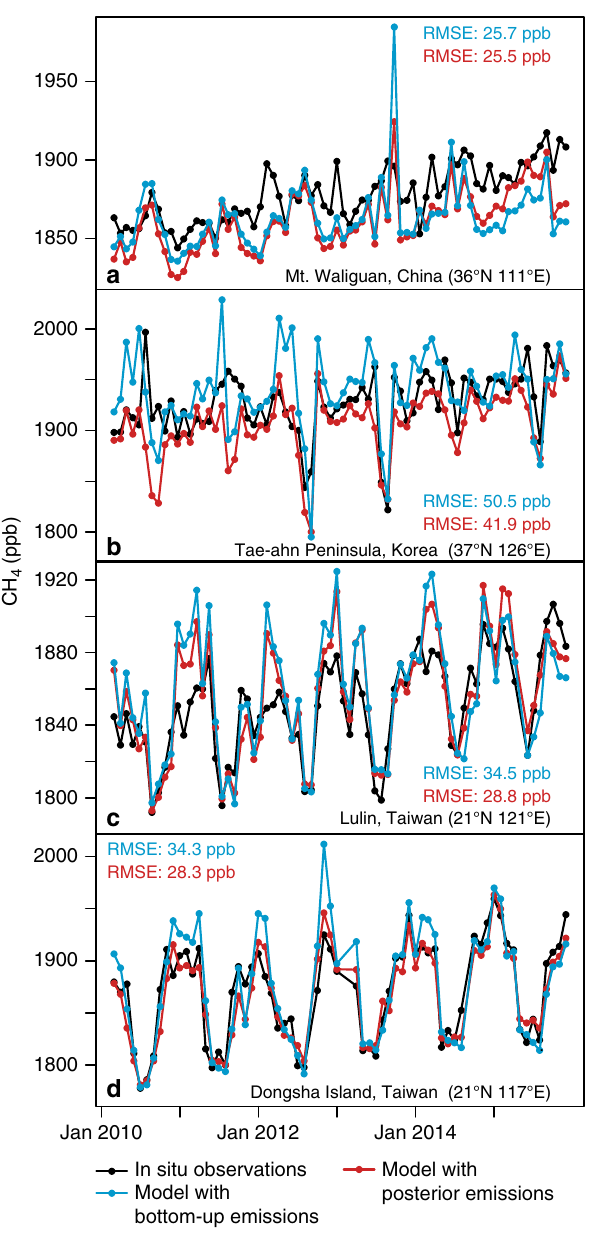
Fig. 4 Observed and modeled CH 4 in situ mixing ratios. The sites shown are in situ monitoring stations from the NOAA Global Greenhouse Gas Reference Network 20 . Modeled CH 4 using the posterior emissions shows a lower root mean squared error (RMSE) at all sites. Note that all panels display monthly model and data means, and the blue modeled time series in this plot use EDGAR v4.2, the same inventory version used in the inverse model